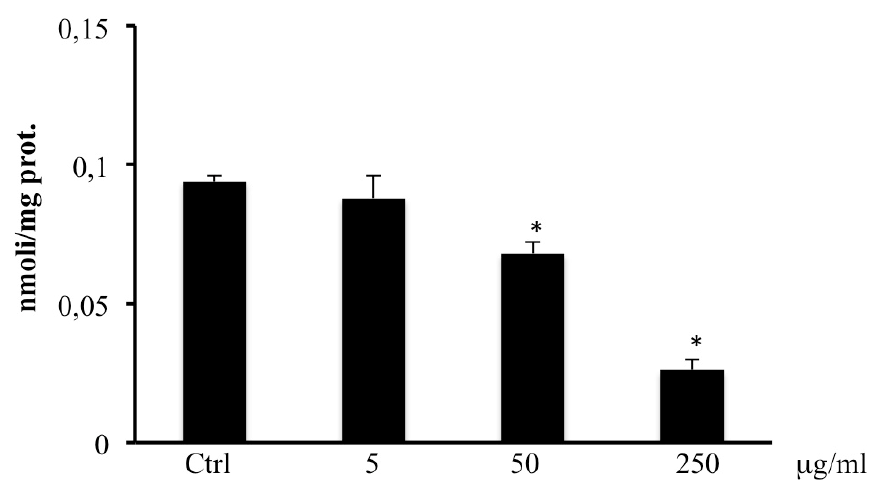
Figure 5. Thiol groups in CaCo2 cells untreated and treated for 72 h with methanolic extract of B. etnensis Raf. at di ff erent concentrations (5–250 µ g / mL). Values are the mean ± SD of four experiments in triplicate. * Significant vs. untreated control cells: p < 0.001.